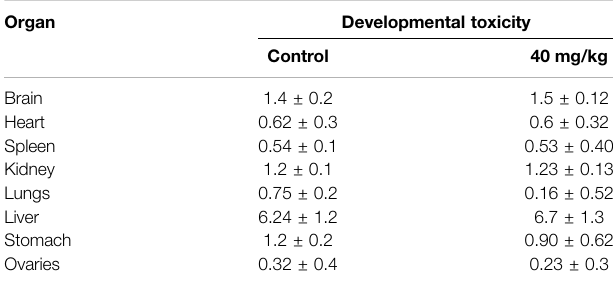
TABLE 6 | Effect of SF5 treatment on the weights of selected organs in the developmental toxicity study.